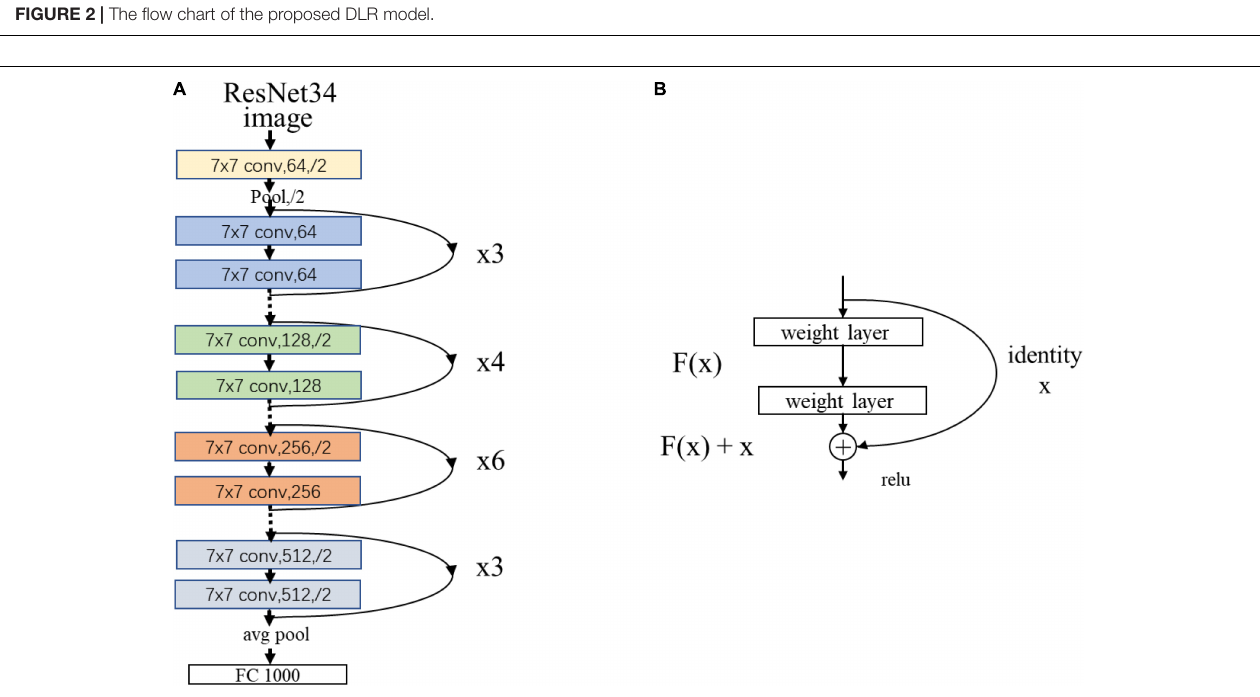
FIGURE 2 | The flow chart of the proposed DLR model.